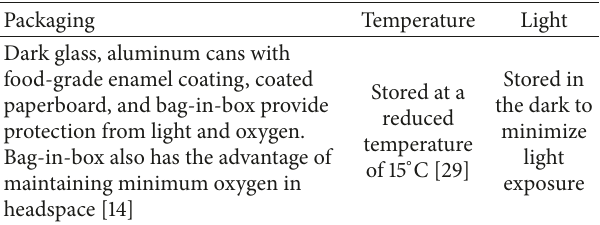
Table 9: Recommended packaging and storage conditions for olive oil shelf